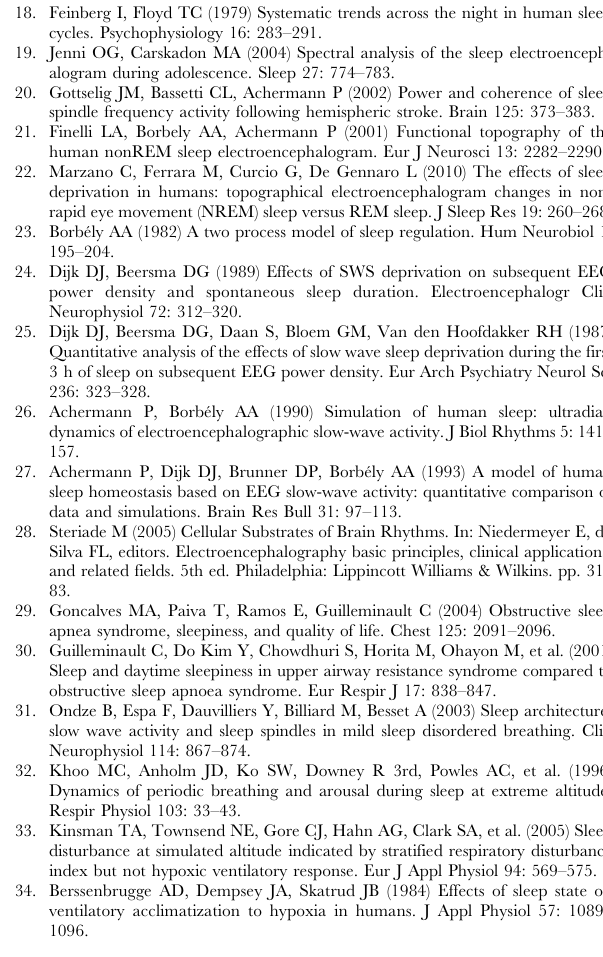
and on the Jakobshorn (two nights each) was randomized. (TIF) Table S1 Sleep variables derived from visual scoring. Data are provided as mean values with standard deviation in parenthesis. Listed are the values averaged over all 44 subjects (TM) and for the two subgroups LH (ascending from lower to higher altitude, n= 23) and HL (descending from higher to lower altitude, n= 21). The difference between the two groups was evaluated by comparing the differences between baseline and altitude values. Post hoc test were performed if factor Condition (pA) of the mixed model ANOVA with factors Condition and Order of altitude exposure was significant. *p , 0.05 (Wilcoxon signed rank test) altitude compared to baseline. { p , 0.05 (Mann- Whitney U test) Comparison of the difference baseline-altitude between the group HL and the group LH. Sleep efficiency is total sleep time as a percentage of time in bed. Sleep stages are reported as percentage of total sleep time. Sleep latency was measured as interval from lights off to the first occurrence of stage 2 sleep. Slow wave sleep is the sum of stage 3 and 4. Time in bed was 7 h. Table S2 Breathing variables and oxygen saturation. Data are provided as medians with median deviation in parenthesis. Listed are the medians over all 44 subjects (TM) and for the two subgroups LH (ascending from lower to higher